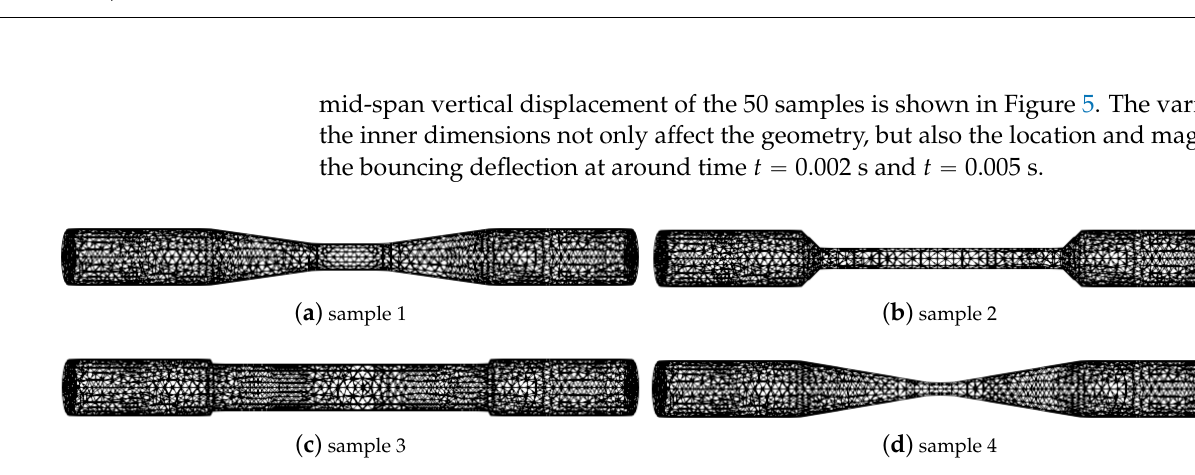
Figure 4. Four samples showing the variability in the beam geometry due to different values of the inner dimensions ( l i , r i ).